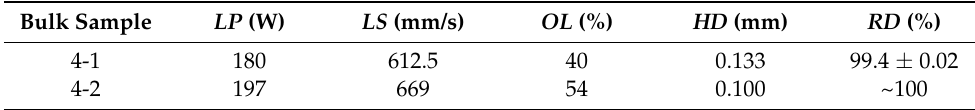
Table 2. Selected process parameters for the test of bulk